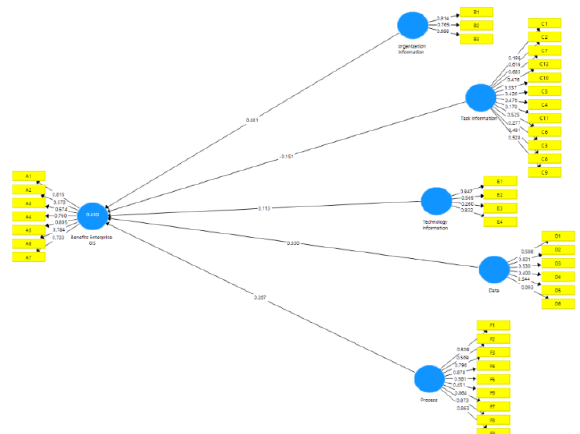
Figure 3. Structural Model Results with value relationship